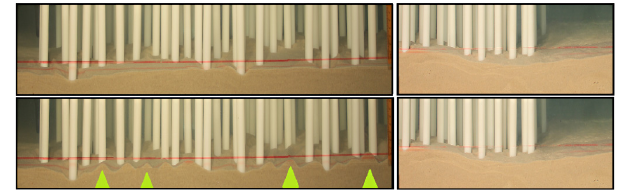
Figure 9. Side view: upstream (left) and downstream (right) edge of the array, before (up) and after (down) 50 waves, H = 0 . 05m, T = 2 . 5s, n = 150m − 2 . Notice the scour and bedforms forming within the array at the upstream section (as pointed by the green arrows) while the downstream section remains unaltered. Notice the factor of 2 increase in the vertical scale.